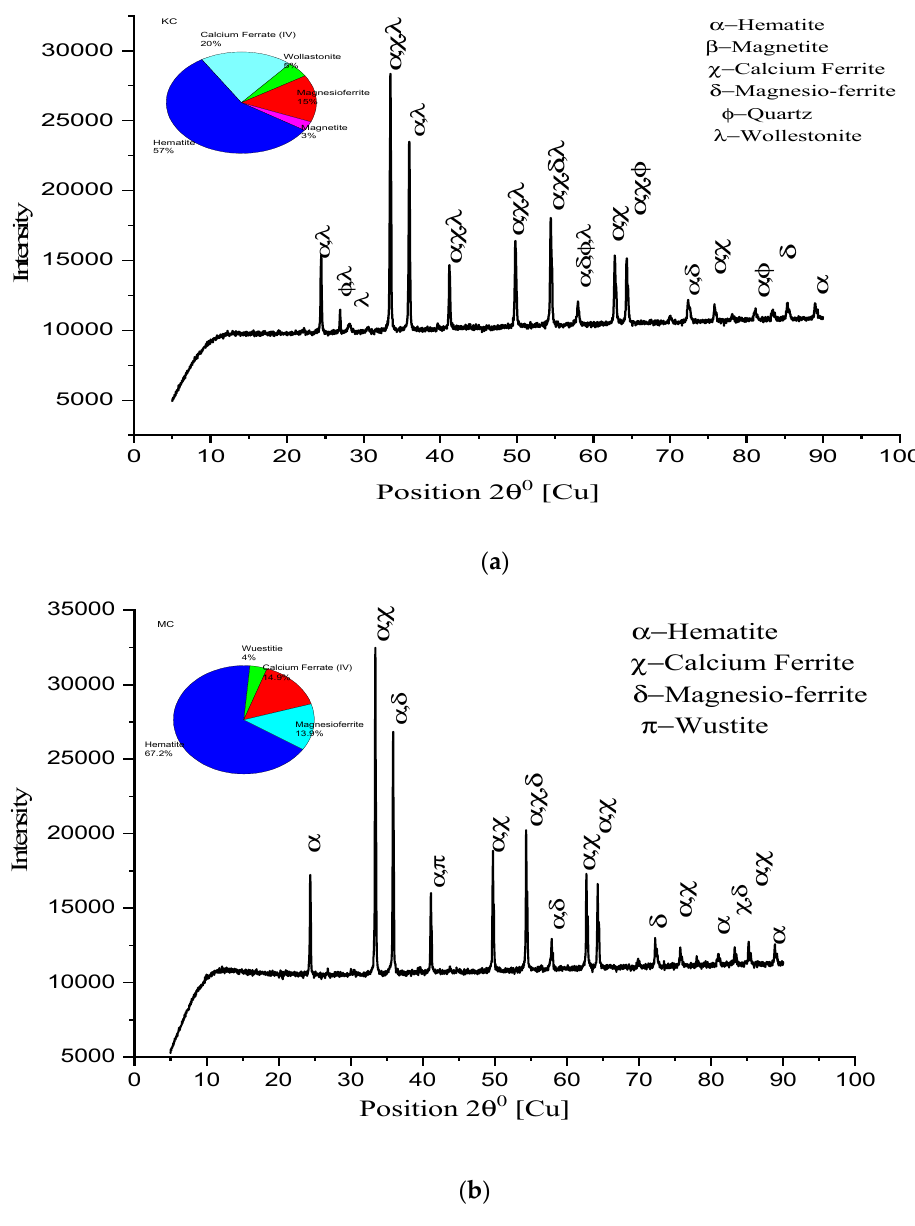
Figure 14. XRD patterns of pellet ( a ) K2C and ( b ) M2C .